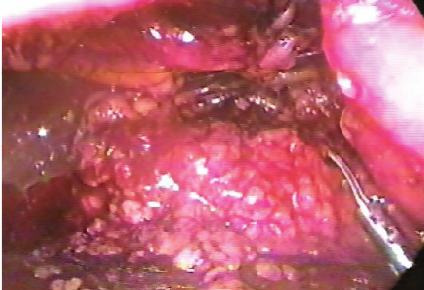
Figure 2: Retroperitoneal lipoma is a yellow lobulated and encap- sulated mass under laparoscopy.